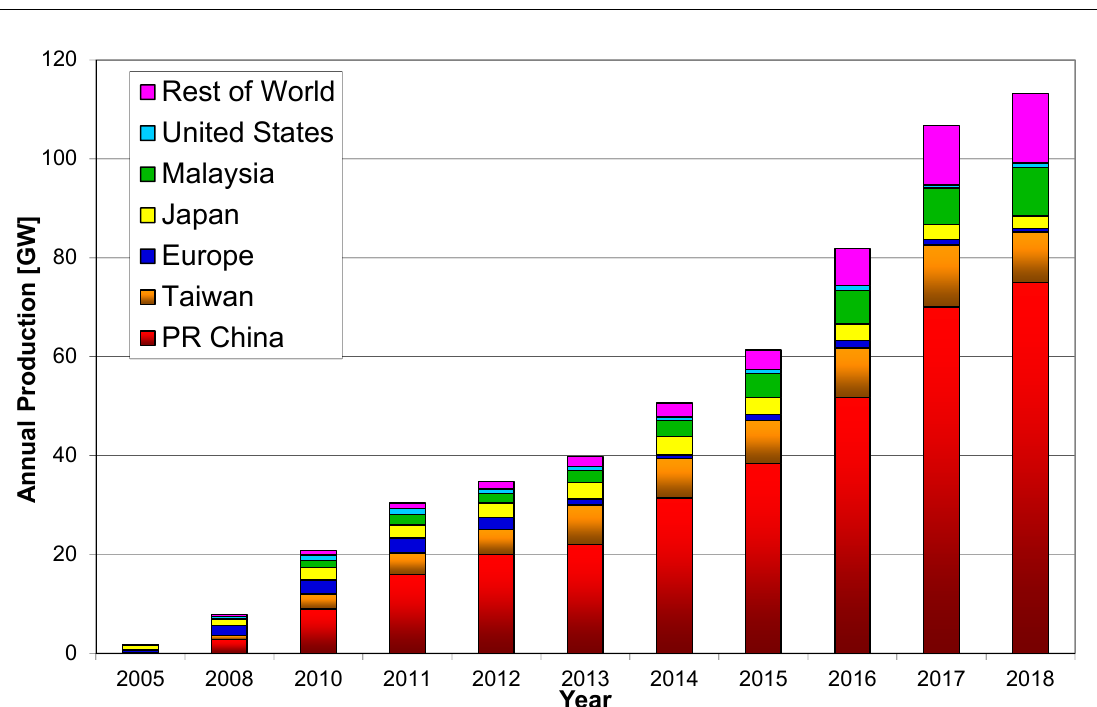
Figure 1. World photovoltaic (PV) cell/module production from 2005 to 2018.